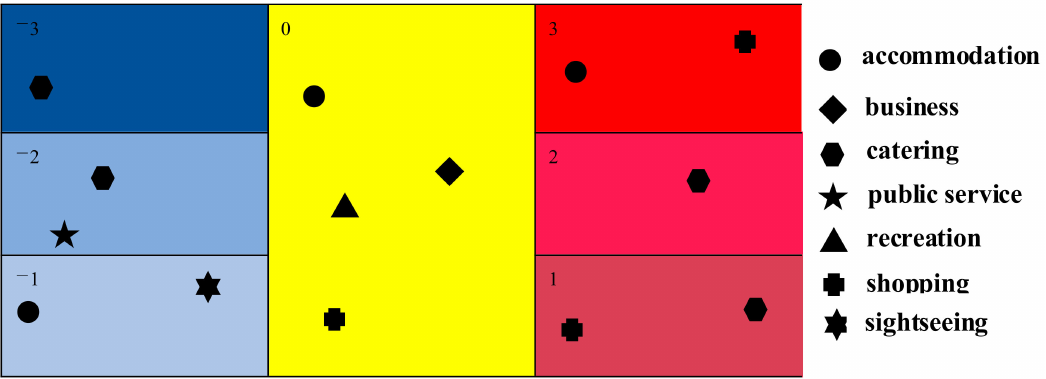
Figure 11. Hot/cold spot overlay with the POI dataset.